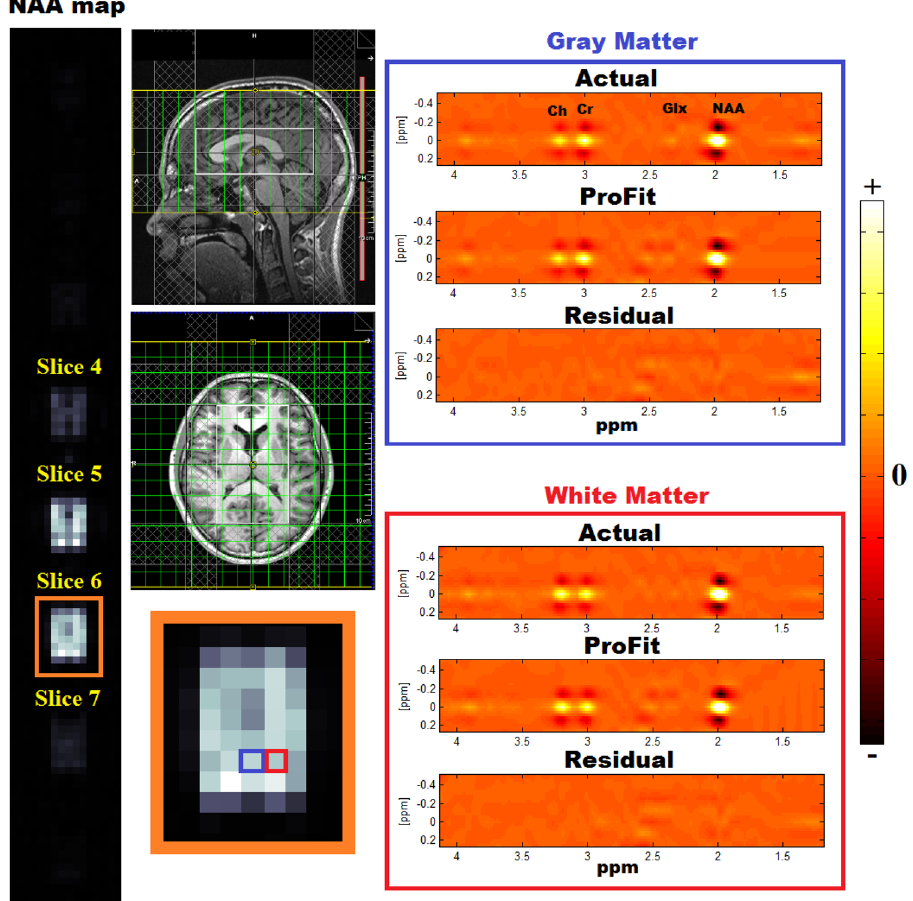
Figure 7. The NAA metabolite map from a healthy adult (age = 20 years old) is shown (left) alongside sagittal and axial T 1 -weighted MRI (middle). Two voxels from slice 6 were identified as occipital gray matter (blue) and white matter (red). These two voxels were fit using ProFit (right), and the real part of the spectrum is displayed. Due to the mixed phase of the peaks, negative side-lobes are apparent for the singlets NAA, Cr, and Ch. Fit residuals for both voxels are very low, demonstrating the reliable fitting of